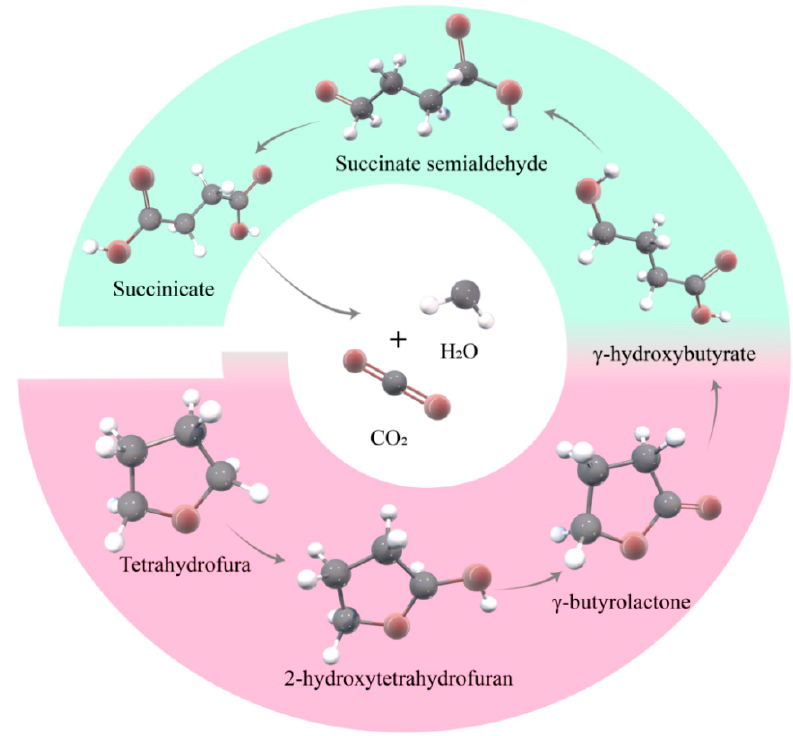
Figure 4. Degradation process of tetrahydrofuran in 3D-BERs.